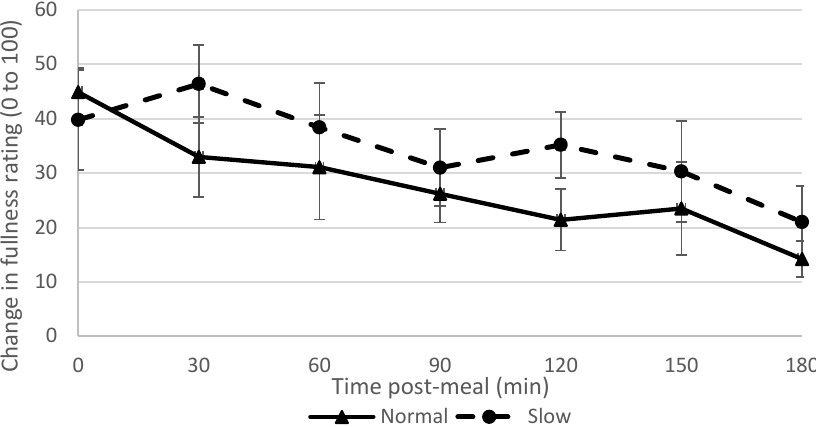
Figure 3. Fullness ratings over time in normal and slow rate groups (error bars = S.E of the mean).